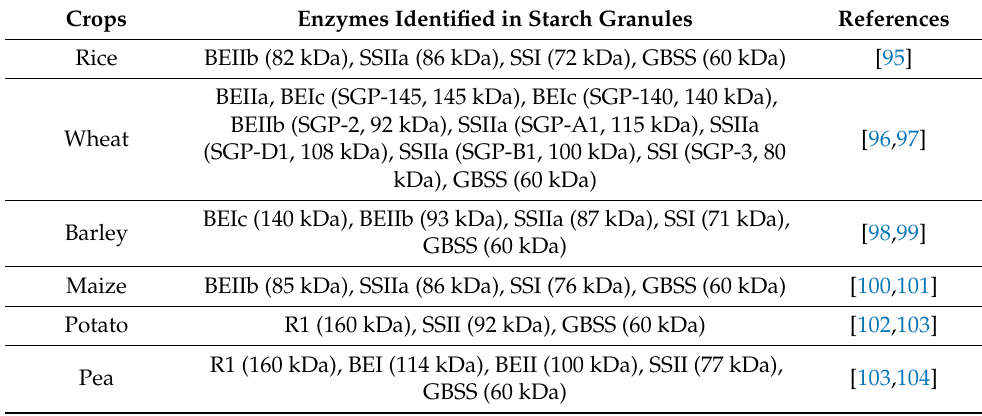
Table 2. Internal starch granule associated proteins in crops [91].